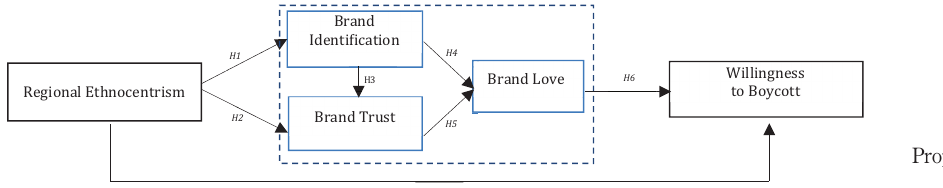
Figure 1. Proposed